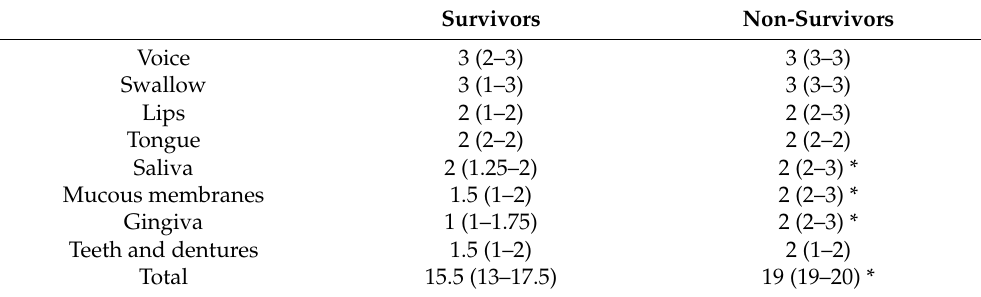
Table 5. Median OAG-F scores on discharge.